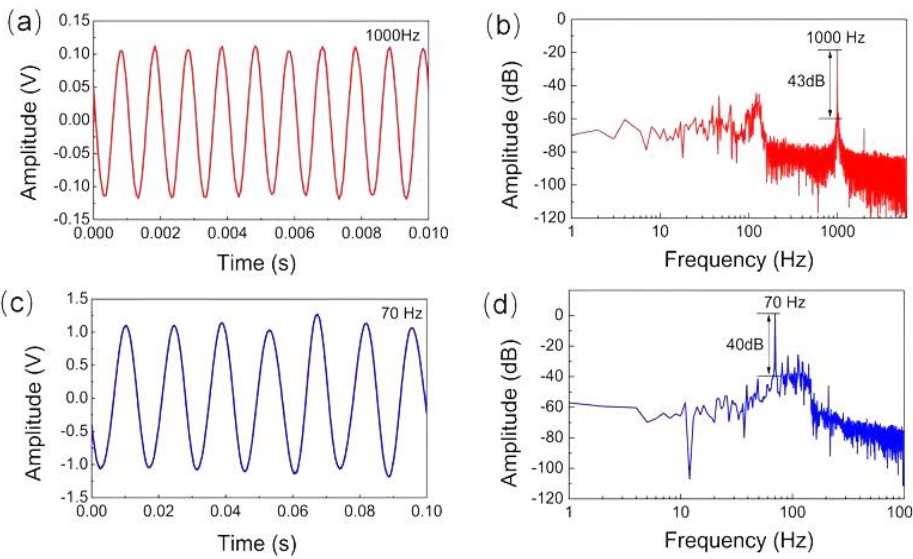
Figure 10. Temporal responses of the fiber-optic microphone to waterborne sounds and the corresponding FFT spectra, ( a , b ) with 1k Hz waterborne sound, ( c , d ) with 70 Hz waterborne sound.